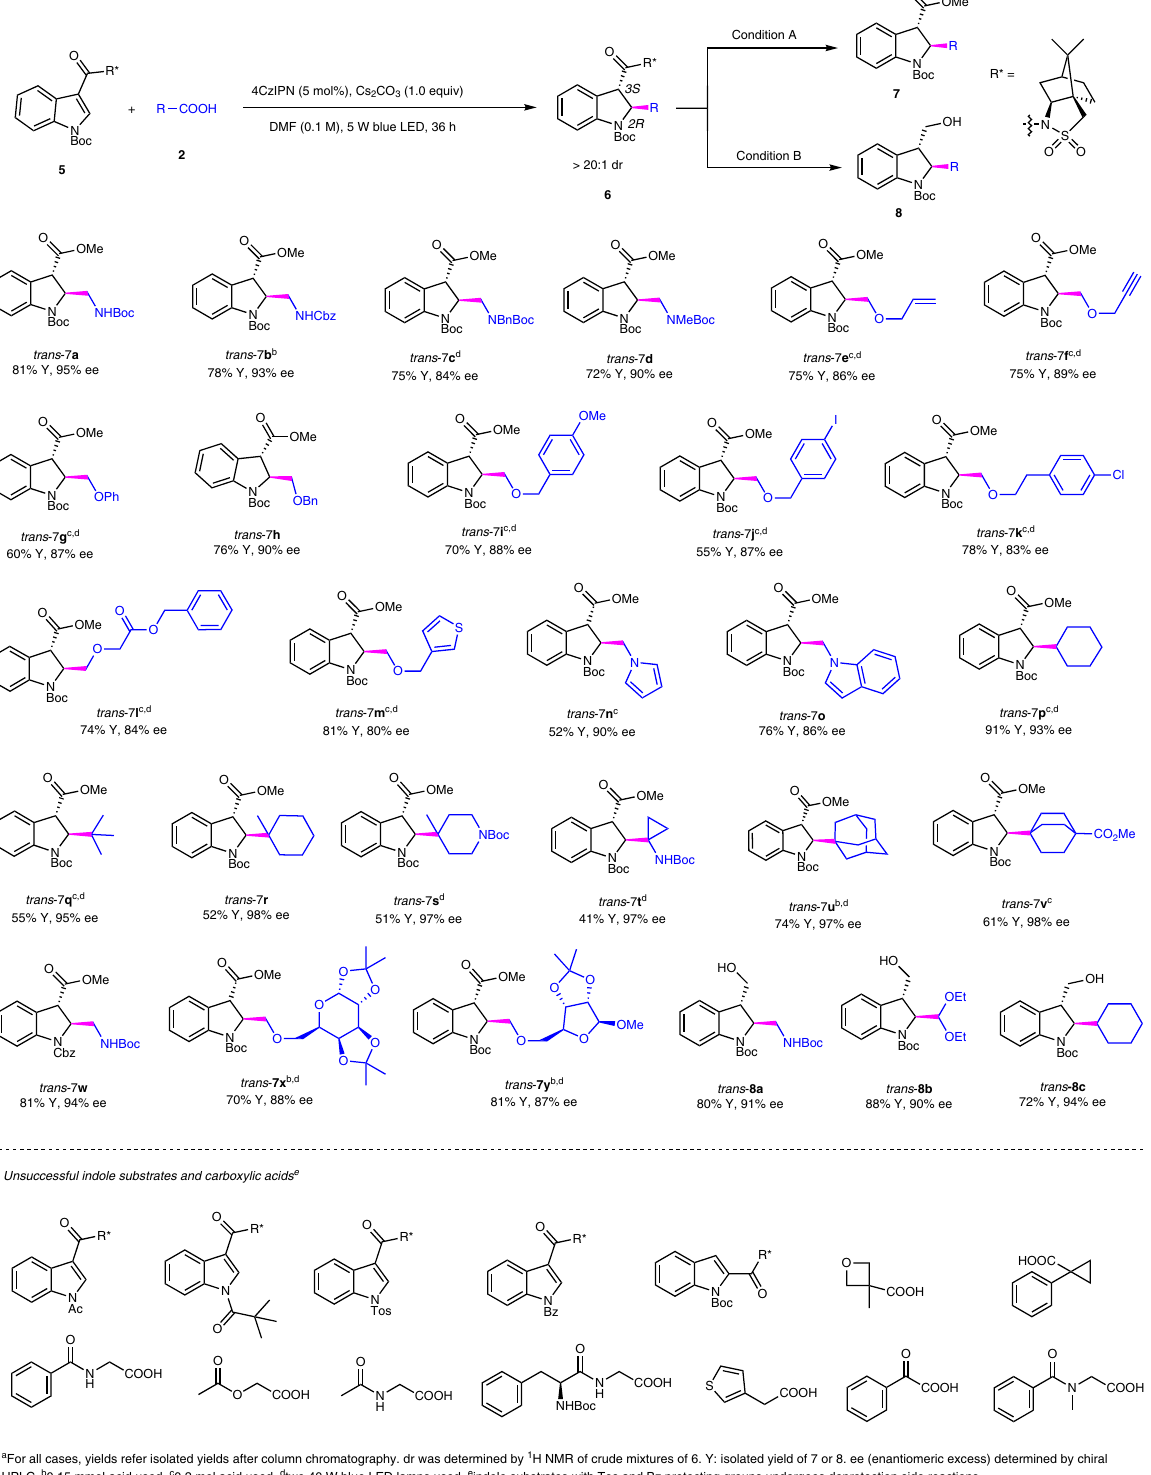
Fig. 5 Scope of asymmetric dearomatization of indoles. Unless speci fi ed, see the general procedure in Supplementary Methods Section 1.6 for the experimental